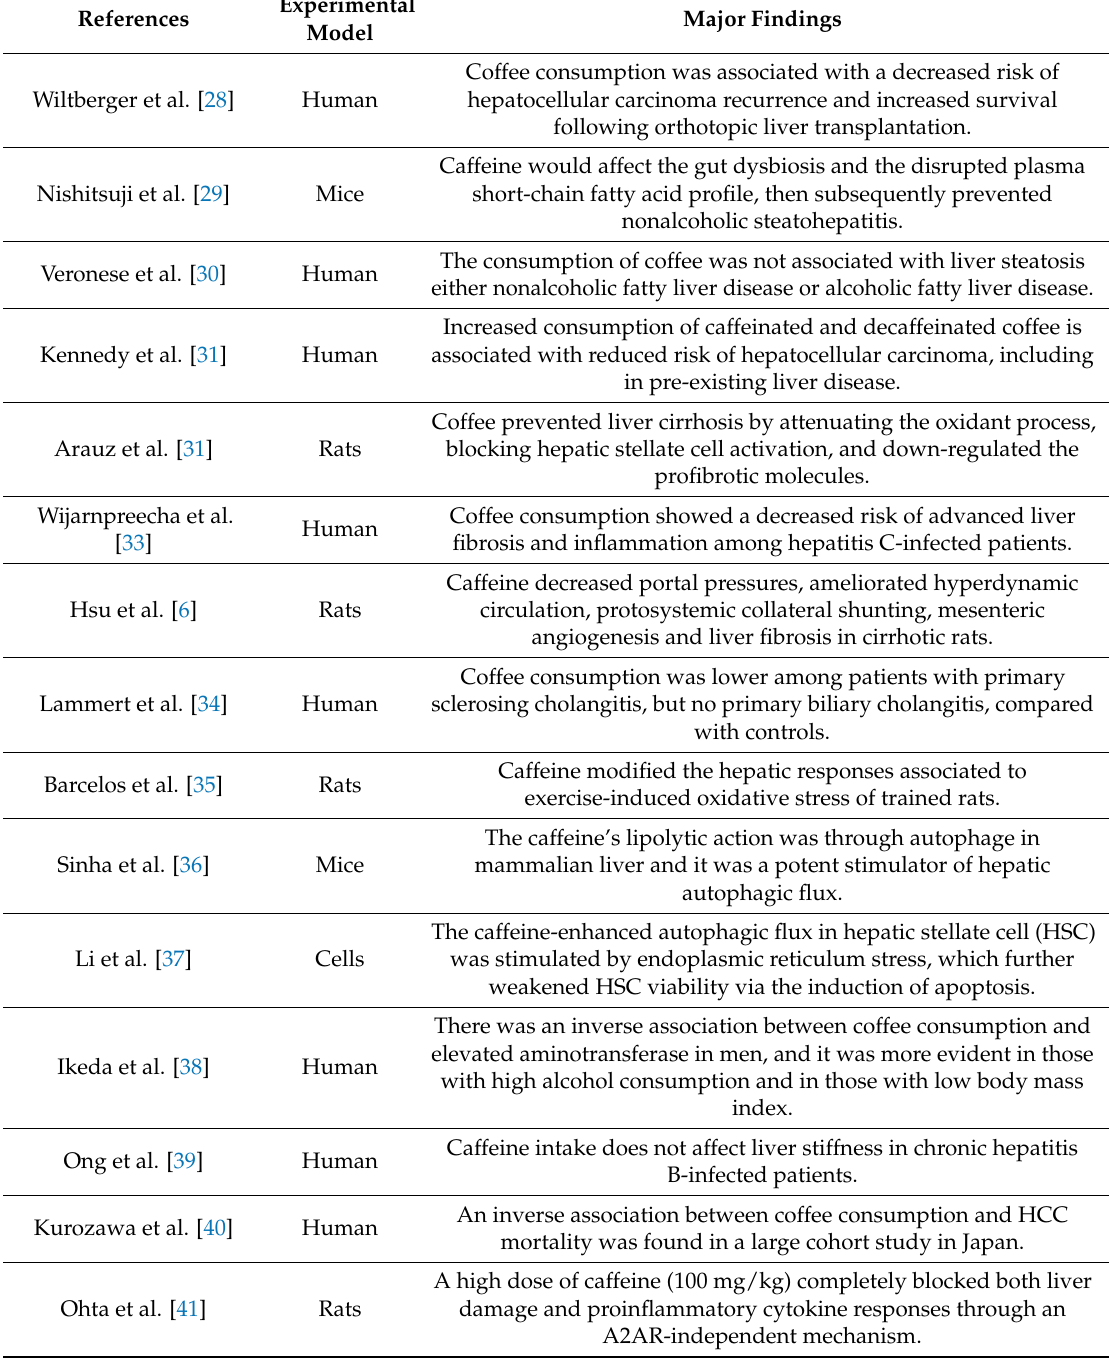
Table 2. Emerging evidence of coffee or caffeine treatment on various liver